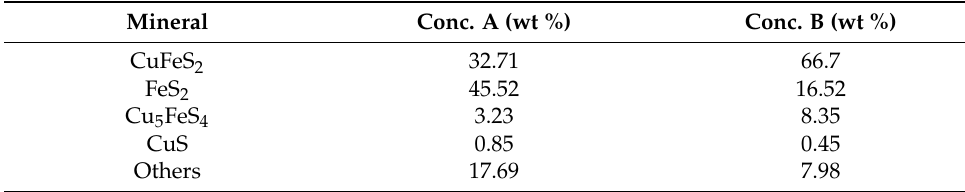
Table 1. Copper concentrate mineralogical